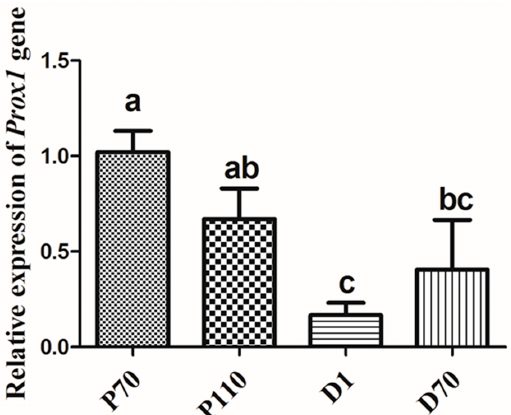
Figure 2. Expression pattern of porcine Prox1 at different developmental stages. Longissimus dorsi muscles were collected from three fetuses of Landrace pregnant females at 70 days (P70) and 110 days (P110) post conception (dpc), and from three pigs on day 1 (D1) and at 70 days (D70) after birth. Real-time PCR was performed to determine Prox1 expression levels. All PCR reactions were performed in triplicate for each sample. The relative expression levels were calculated using the 2 -△△ct value method and normalized with porcine housekeeping gene HPRT . Statistical analysis was performed using one-way ANOVA with Duncan’s multiple range tests. Data are presented as the mean ± SEM (n = 3). Di ff erent letters above the bars indicate significant di ff erences. Note: p < 0.05.